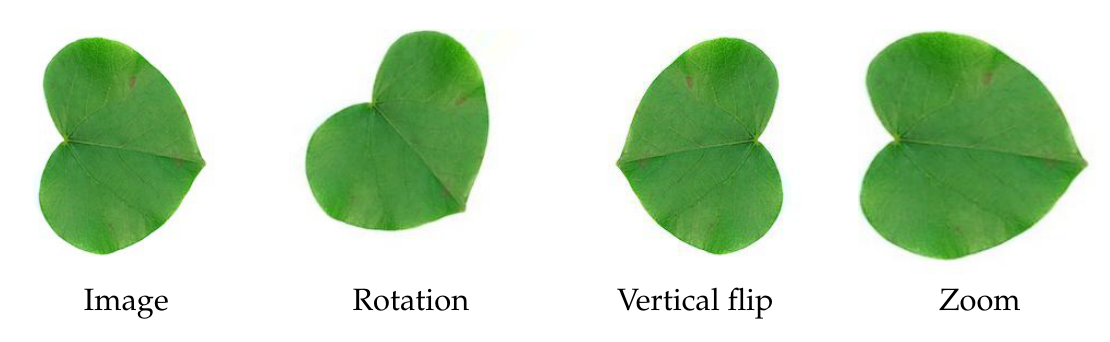
Figure 7. Transformations examples.